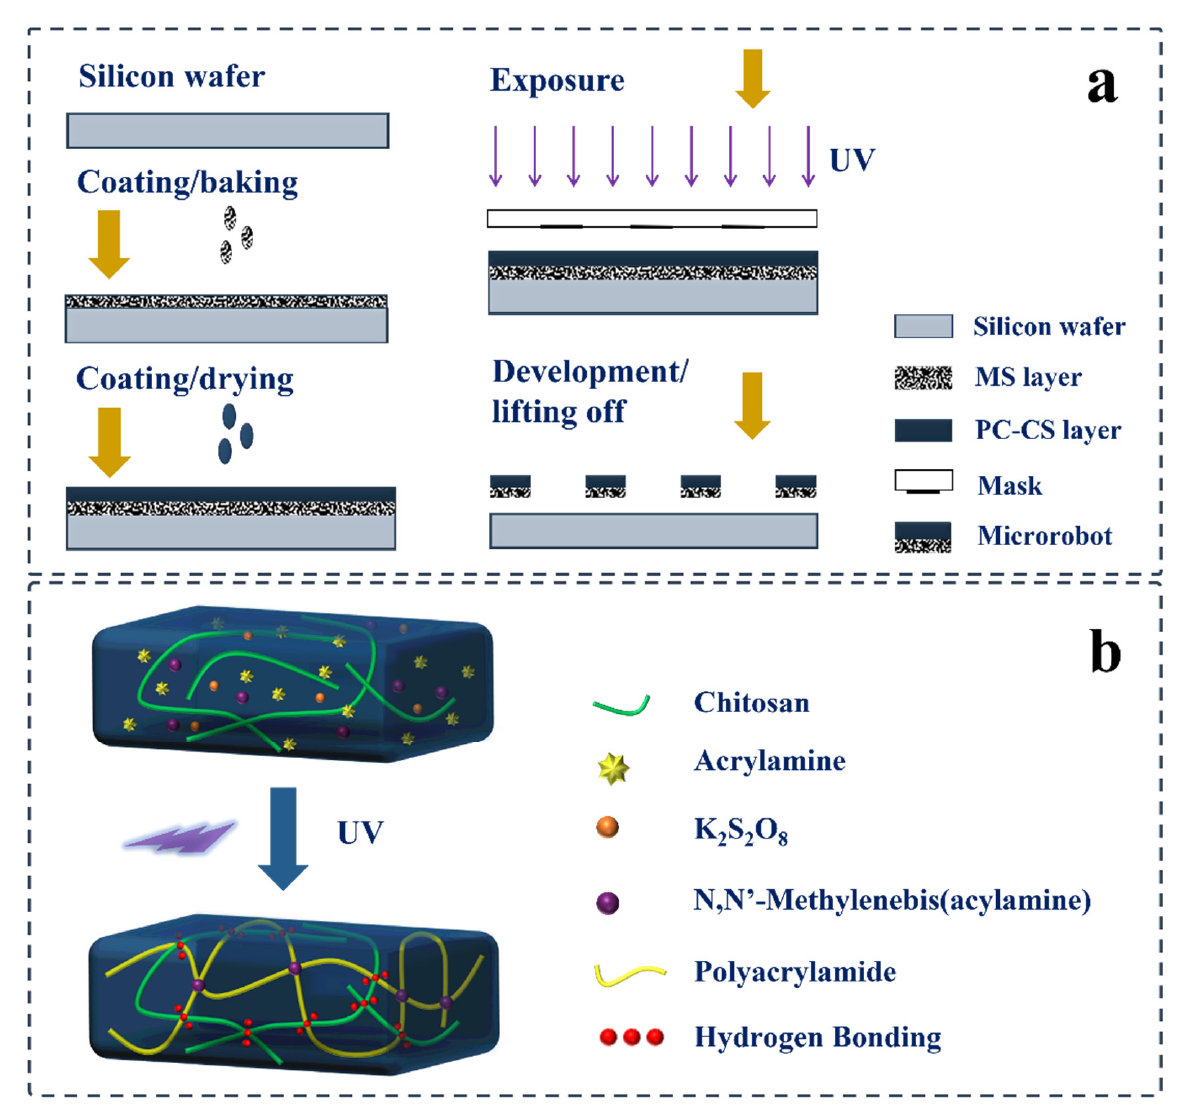
Figure 1. ( a ) Fabrication of chitosan-based achiral planar microrobots. ( b ) Schematic illustration of the photo-crosslinking process for the top layer.